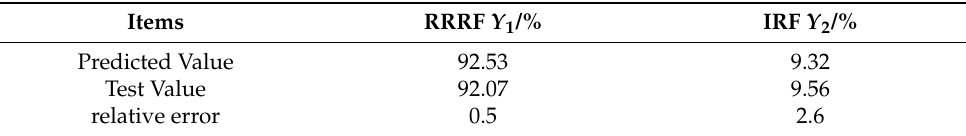
Table 4. Verification test